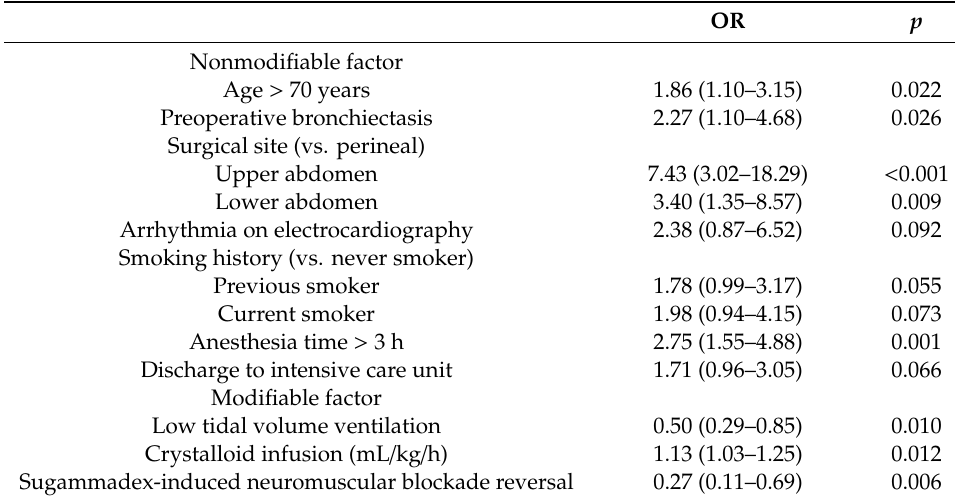
Table 3. Multivariable